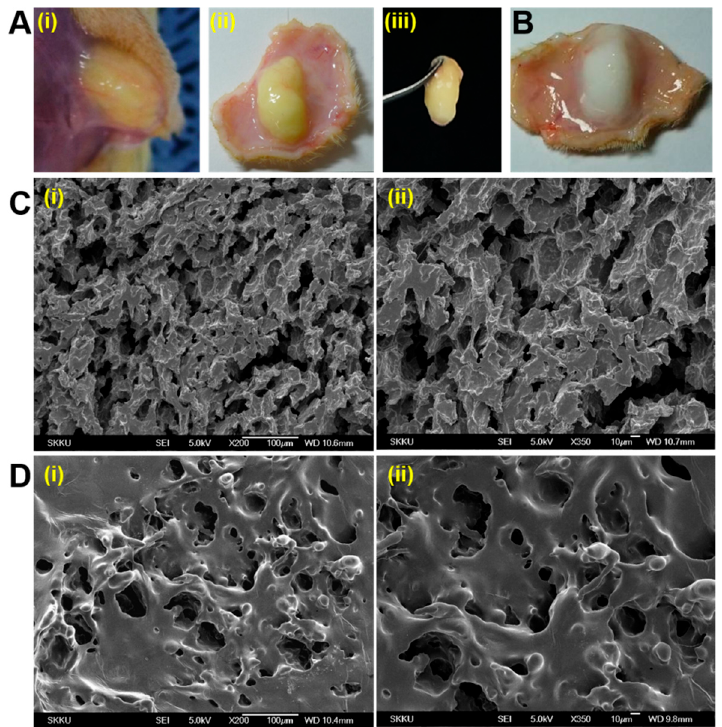
Figure 8. In situ gel formation in vivo. ( A ) Subcutaneous injection of 300 µL of Lys-PCLA conjugates (22.5 wt.%). (i) opening of the hydrogel nodule, (ii) recovery of the hydrogel, and (iii) separating the gels from subcutaneous tissues that shows the stability retainment. ( B ) PCLA hydrogel depot implanted using 300 µL of PCLA copolymers (22.5 wt.%). SEM images showing the microporous network of ( C ) Lys-PCLA and ( D ) PCLA hydrogels recovered after subcutaneous implantation. (i) and (ii) are for the low and high magnification images.